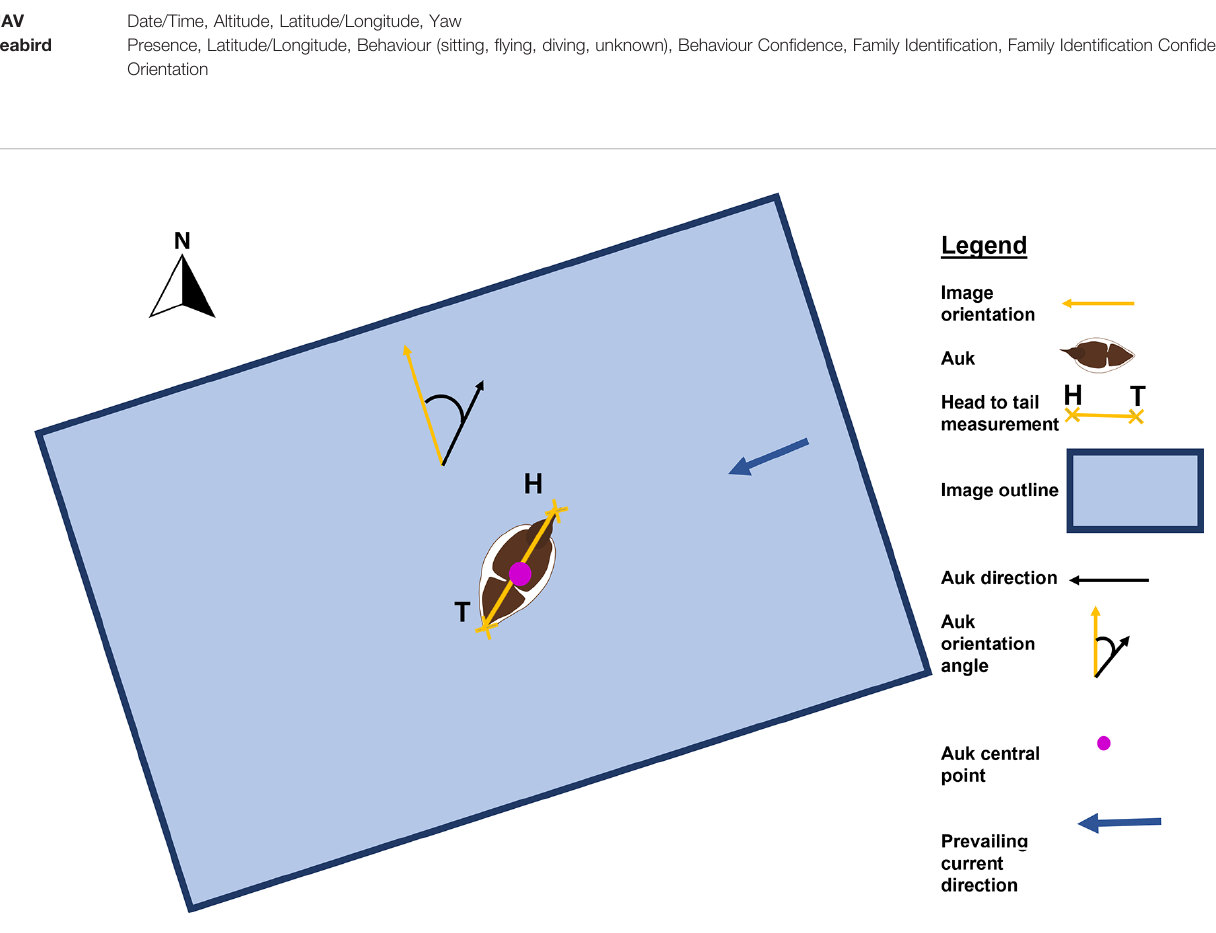
FIGURE 2 | Metrics obtained from UAV imagery including bird central point, head (H) to tail (T) measurements and orientation